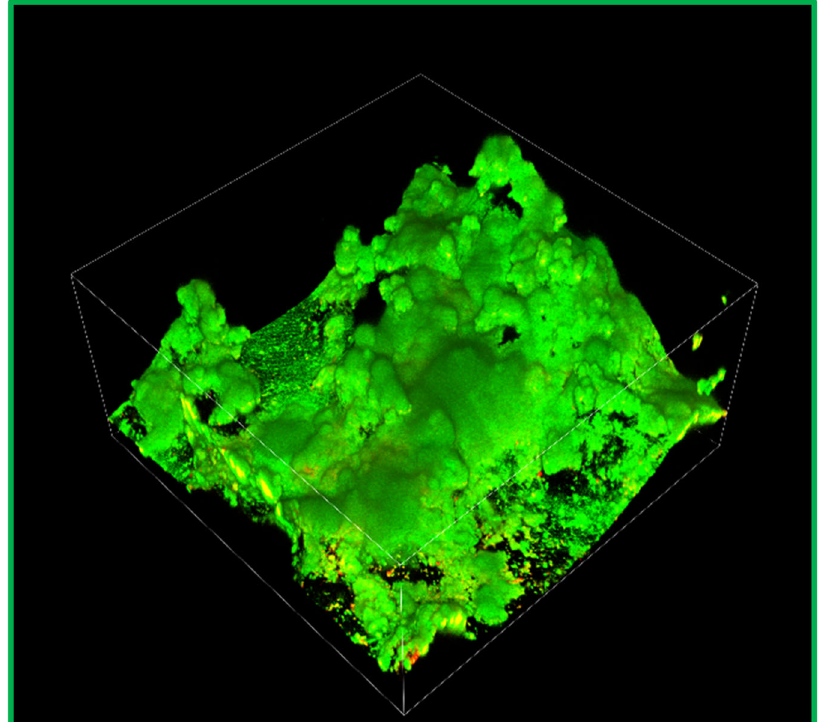
Fig. 3 Confocal laser scanning microscopy of a marine bio fi lm formed on steel. Confocal micrograph of a marine consortium under 20× objective demonstrating bio fi lm topography, surface coverage and cell viability on carbon steel (ASI 1030), where green corresponds with live cells and red corresponds with dead or damaged